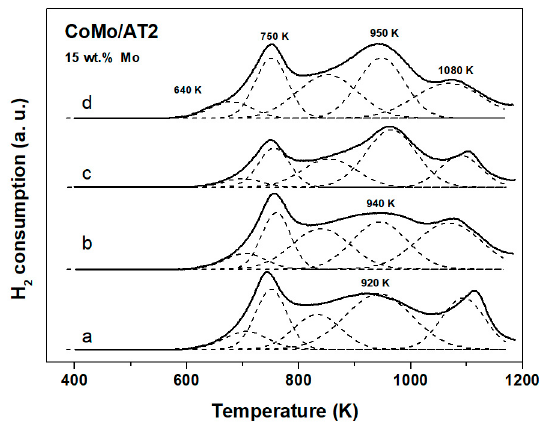
Figure 12. TPR profiles of CoMo / AT2 calcined catalyst at 15 wt.% Mo with di ff erent Co / (Co + Mo) ratios: ( a ) 0.1, ( b ) 0.2, ( c ) 0.3, and ( d ) 0.4.